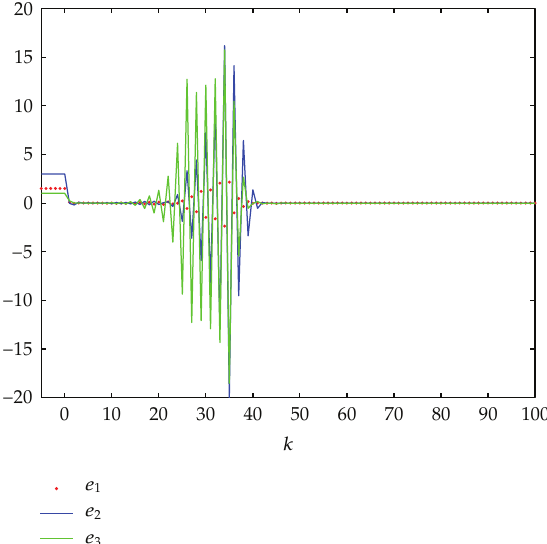
Figure 2: Error state trajectories of e (cid:2) k (cid:3)